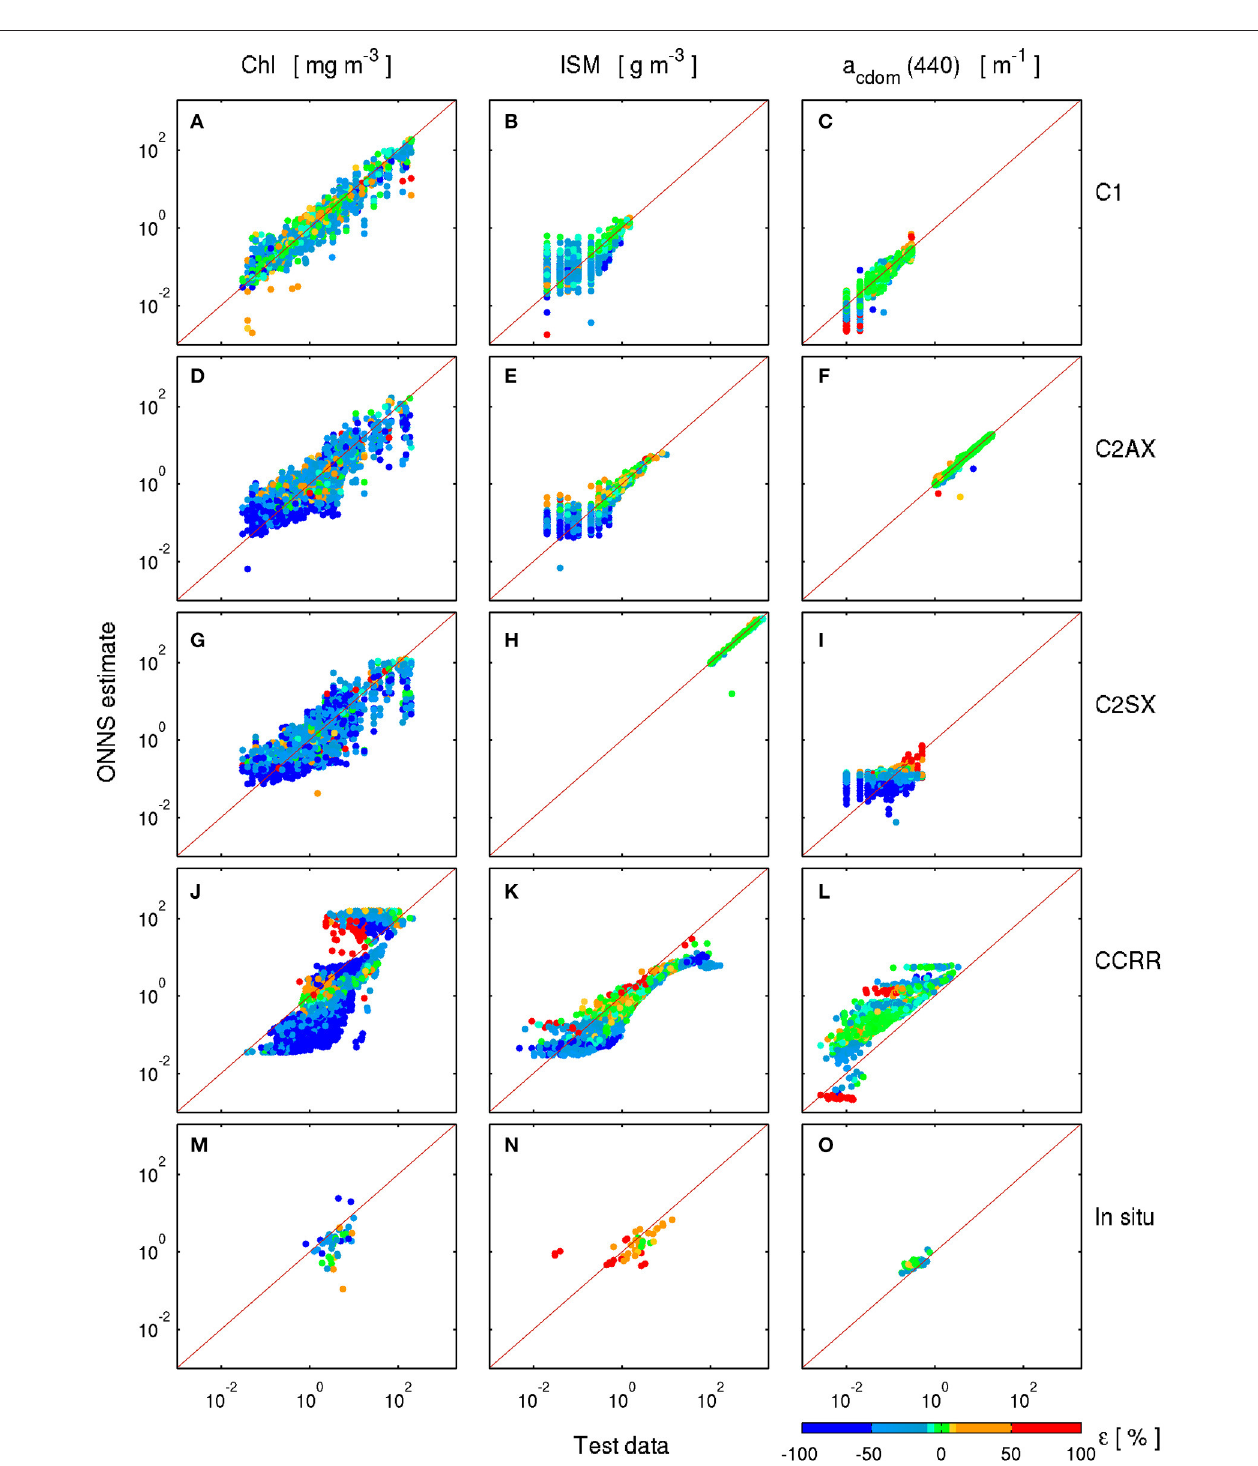
FIGURE 4 | ONNS retrieval capacity for chlorophyll concentration (left), concentration of inorganic suspended matter (center column), and CDOM absorption at 440 nm (right) in comparison with simulated and in situ validation data. (A–C) : Case-1 data from database, (D–F) : Case-2 extreme absorbing waters, ( G–I) : Case-2 extreme scattering waters, (J–L) : simulated data from CoastColour Round Robin (Nechad et al., 2015), (M–O) : HZG in situ data. Colors indicate the retrieved uncertainty.